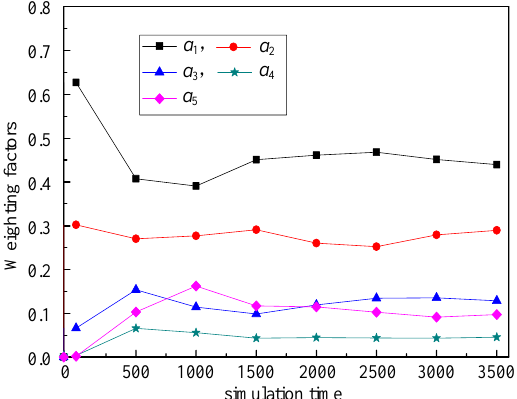
Figure 9. Relationship between weighting factors and simulation time: node 2.